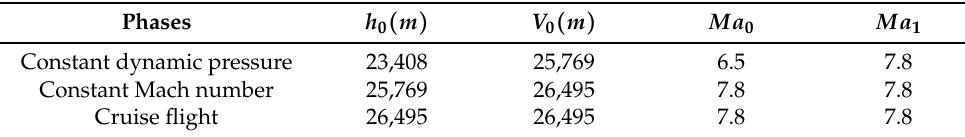
Table 3. Initial points of the different phases.